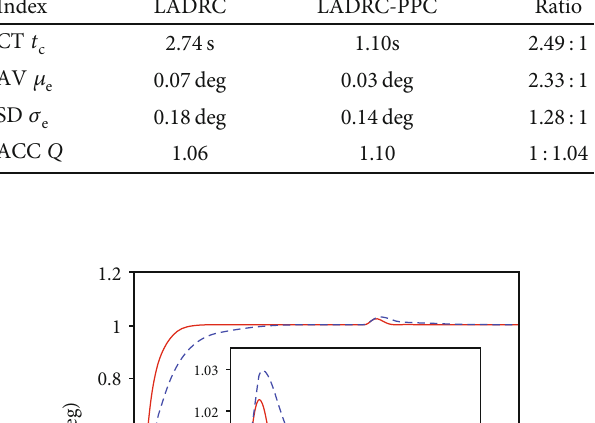
Figure 13: Pitch angular rate.